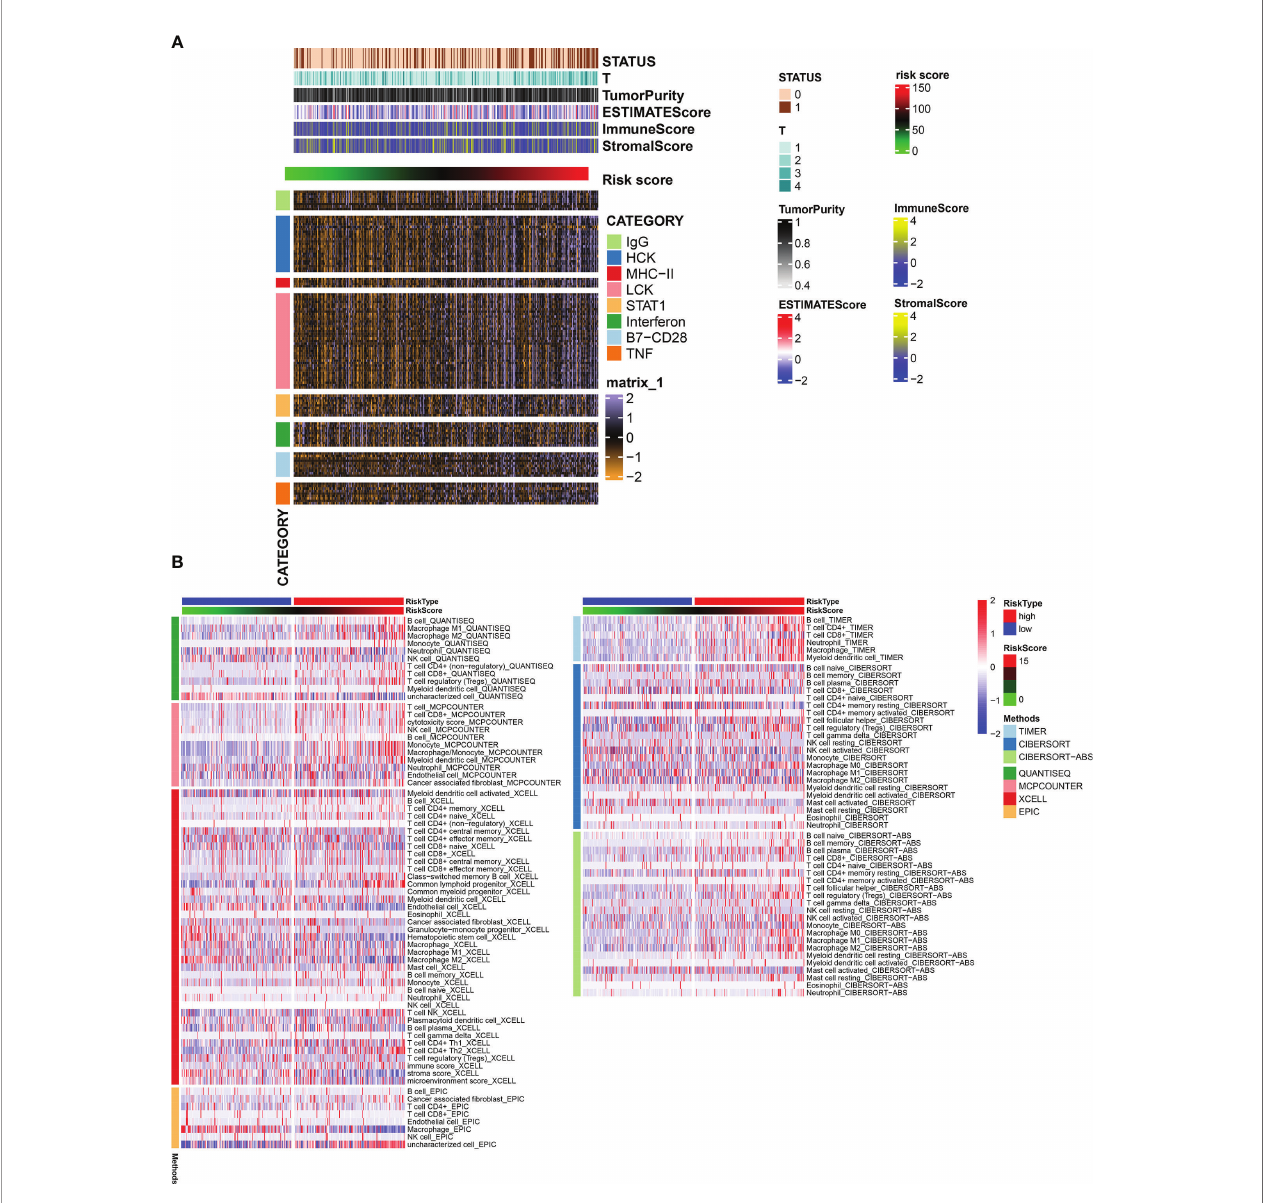
FIGURE 7 | (A) Heatmap for genesets associated with immune and in fl ammation. (B) Heatmap for immune responses based on TIMER, CIBERSORT, CIBERSORTE-ABS, QUANTISEQ, MCPCOUNTER, XCELL, and EPIC algorithms among high- and low-risk